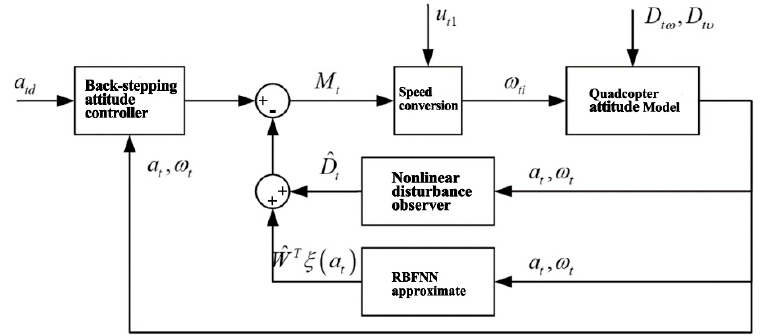
Figure 12. Structural diagram of quadcopter attitude controller.